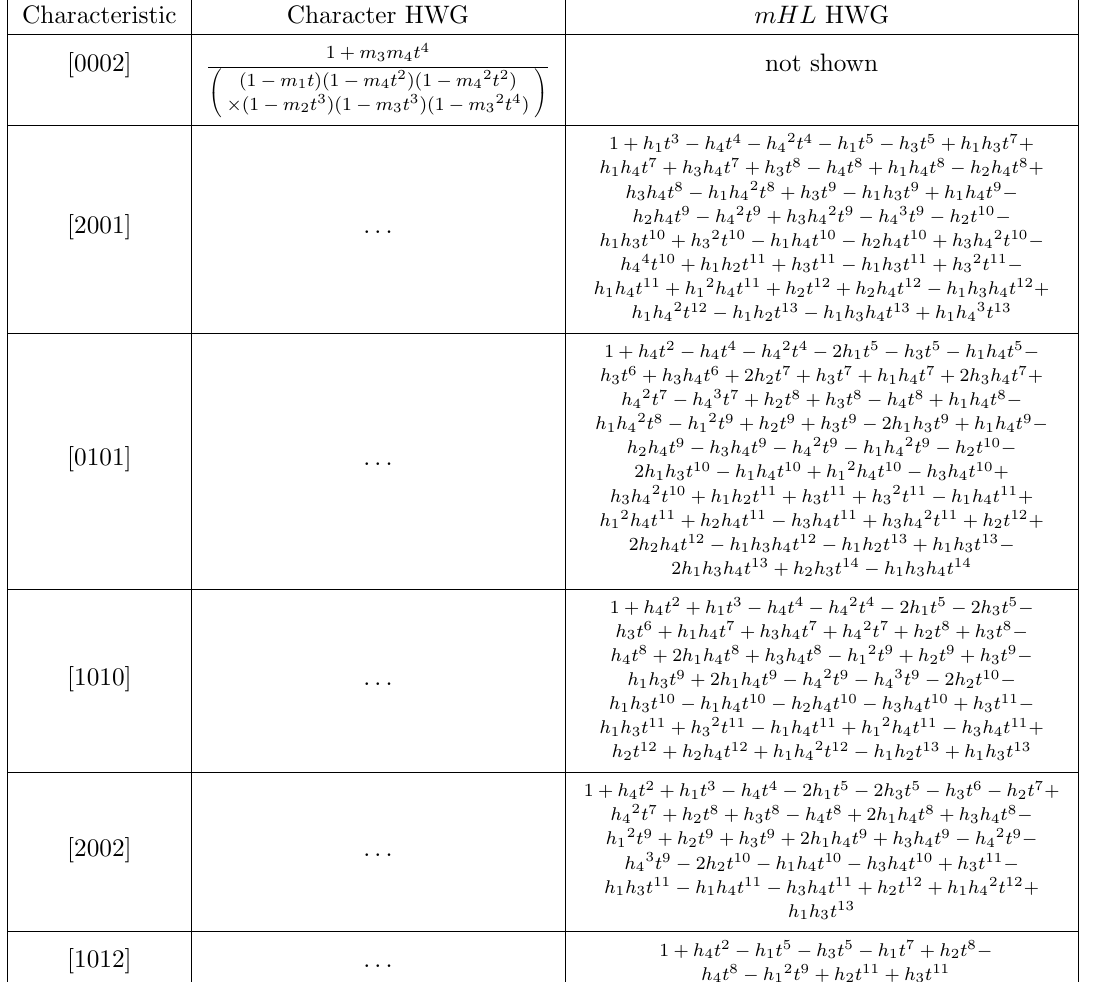
Table 11 . F 4 nilpotent orbit normalisations and HWGs. In addition to the normalisations of non-normal nilpotent orbits, the extension F 4 [2002] is shown (see text).